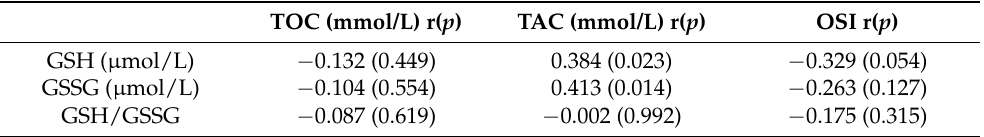
Table 5. Correlations between serum concentrations of total oxidant and antioxidant capacity and glutathione concentrations in bone tumor